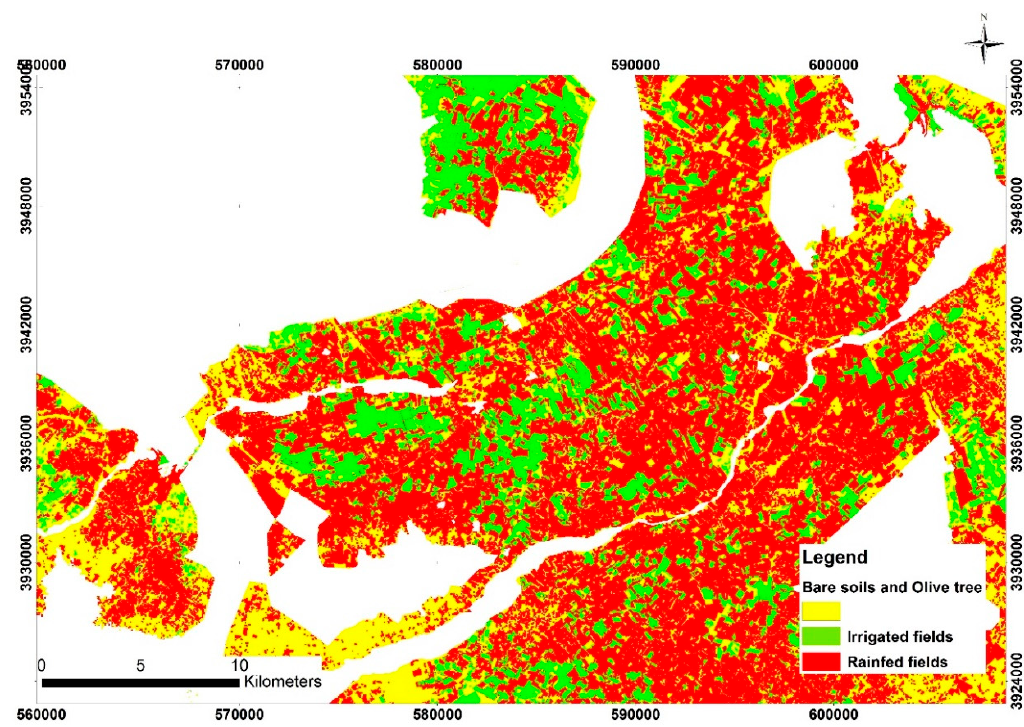
Figure 11. Classification of irrigated and rainfed areas using soil moisture parameters.